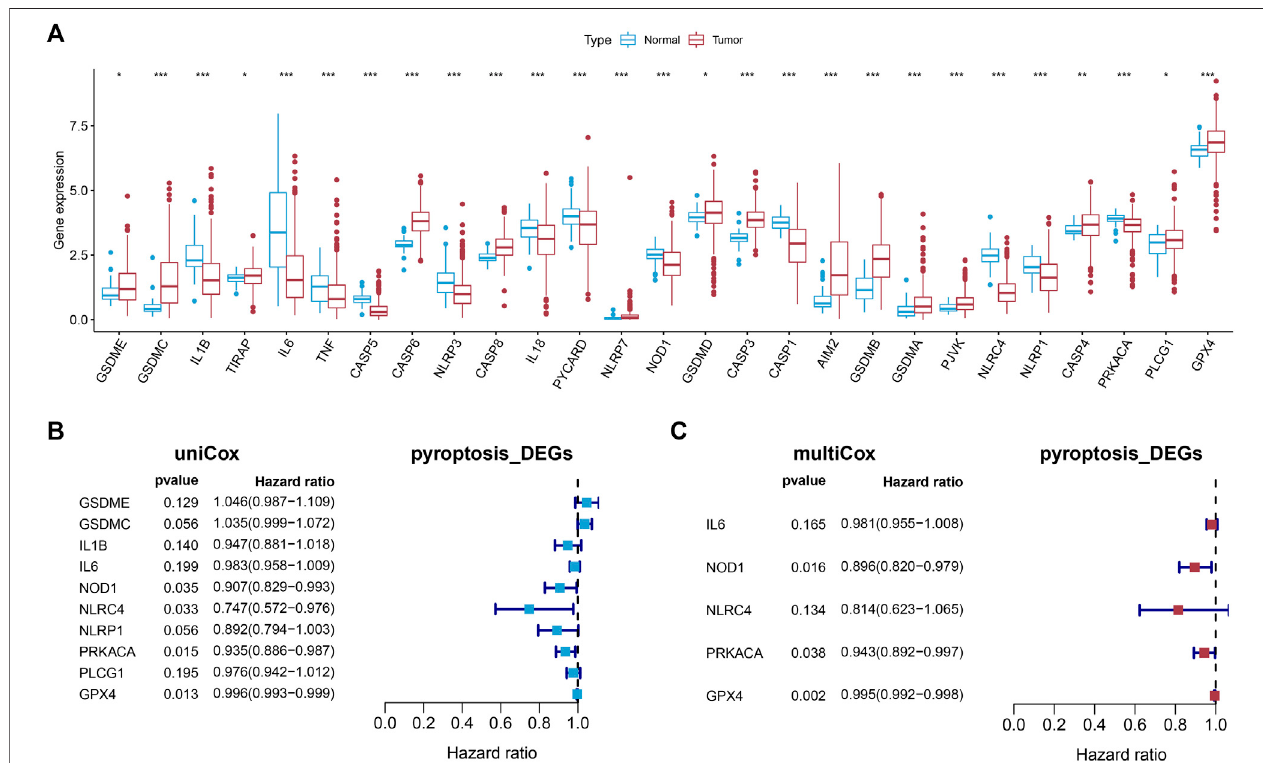
FIGURE 2 | Establishment of the prognostic model. (A) The boxplot showed the differentially expressed PRGs between normal and tumor tissues of LUAD. (B,C) Univariate and multivariate Cox regression identi fi ed the PRGs associated with